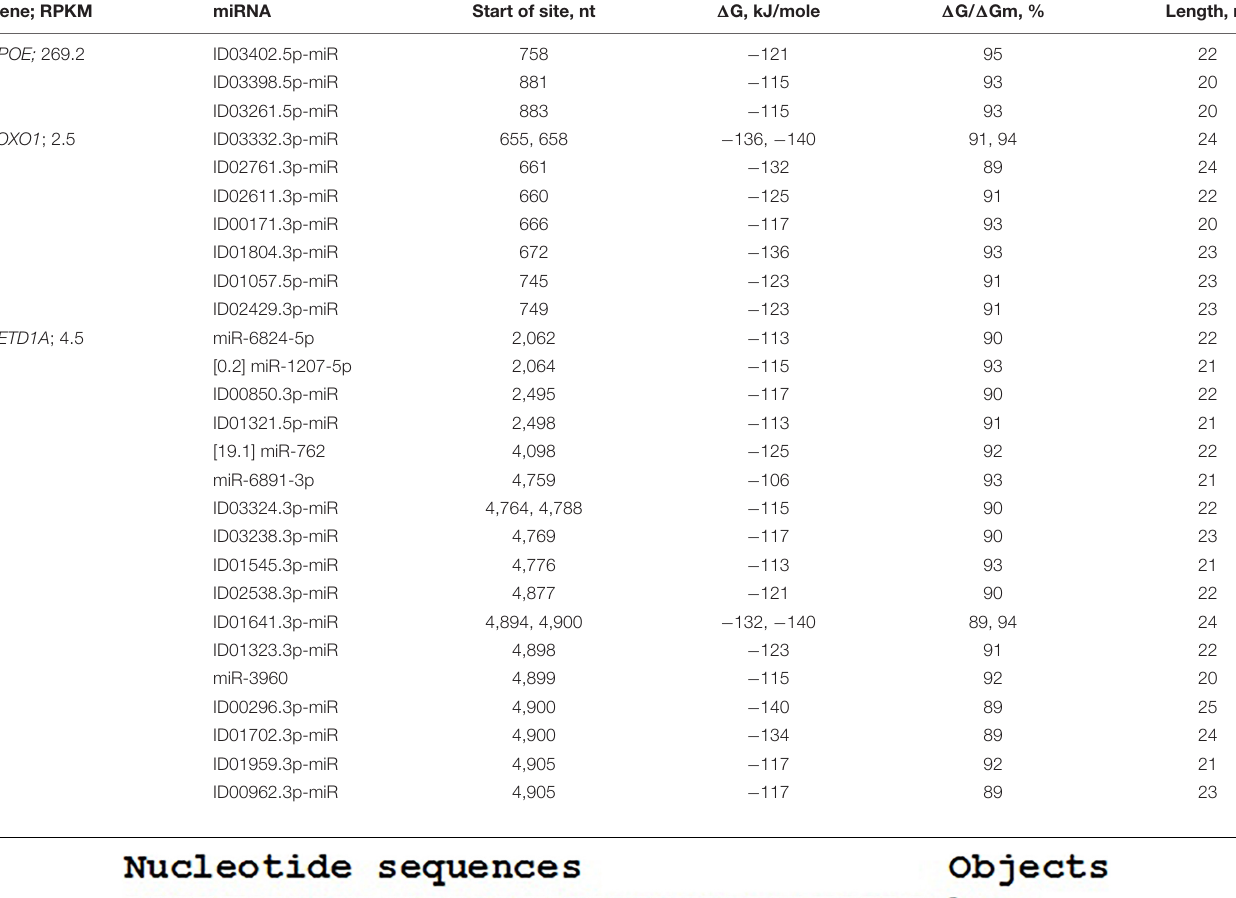
TABLE 2 | Characteristics of the interactions between miRNAs and CDS mRNAs of candidate PD genes. Gene; RPKM miRNA Start of site, nt (cid:49) G, kJ/mole (cid:49) G/ (cid:49) Gm, % Length, nt APOE; 269.2